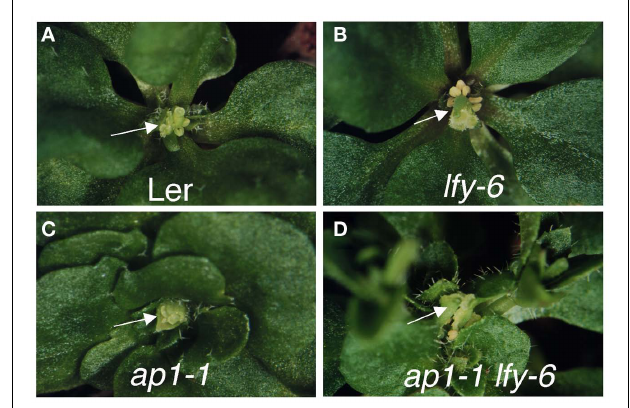
FIGURE 6 |The effect of prolonged early strong activation of LFY. Plants of the genotypes indicated were treated daily from day 3 to day 10 with 5 μ M dexamethasone. In all cases (A–D) , the entire primary inflorescence was converted into a flower.The single terminal flower (white arrow) displayed at least partial rescue of the floral homeotic defects present in lfy null flowers (B,D)